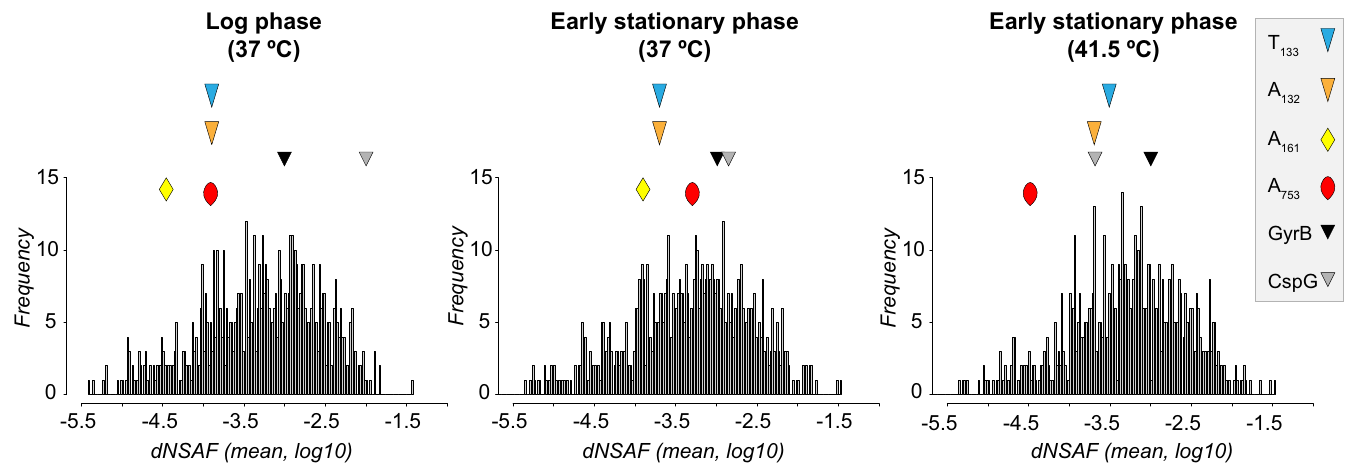
Fig 3. Detection of proteomic signatures of three TA systems investigated in in vitro grown Mmc GM12. The histogram shows relative protein abundance in strain GM12 [frequency over distributed normalized spectral abundance factor (dNSAF)], with candidate toxins (T) and antitoxins marked with different symbols. The analysis is based on three biological replicates. The protein abundance was tested in early log phase, early stationary phase and early stationary phase during heat stress using SP5 medium. Candidate toxins and antitoxins not displayed were below detection limits or absent. We included the house keeping proteins CspG and GyrB for comparison. The figure illustrates the dynamic changes of TA proteomic signatures over time, the TA 132/3 had the strongest signatures and its antitoxin signatures was getting smaller compared to its toxin pair under heat stress.